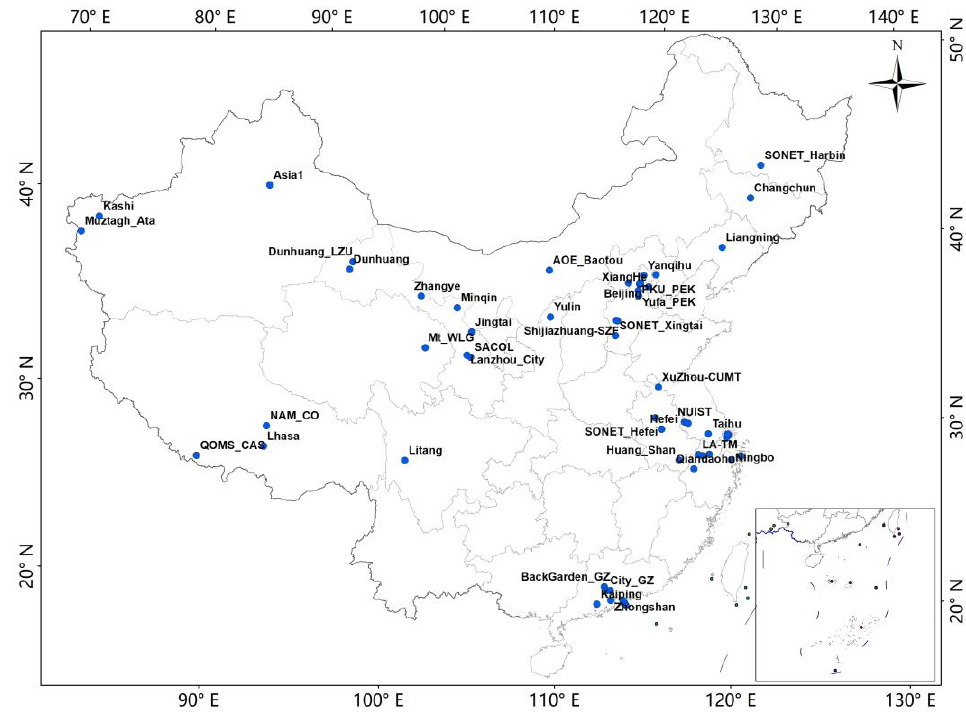
Figure 1. Study area and location of AERONET sites.